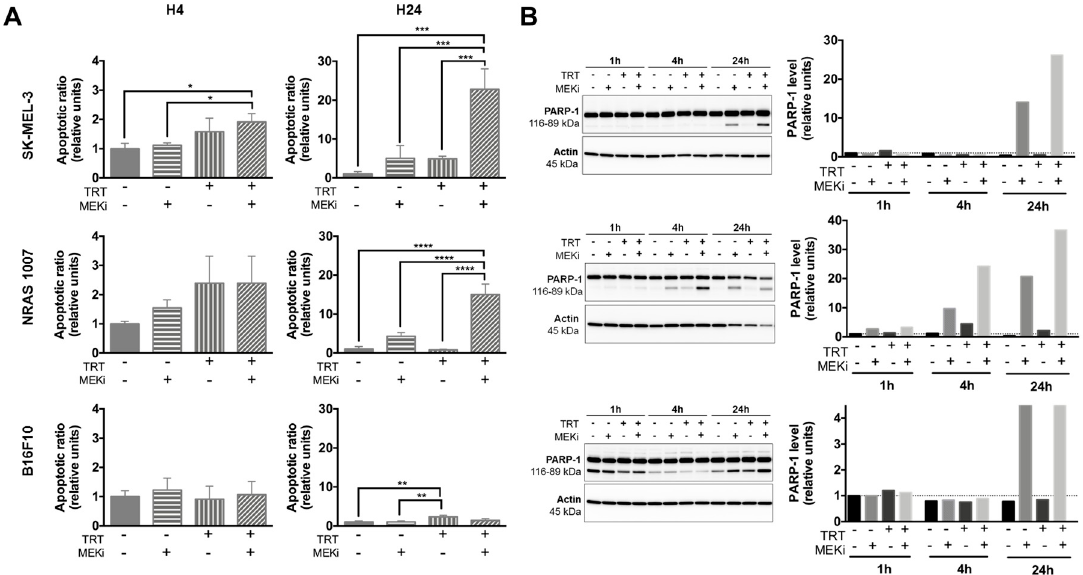
Figure 1. Apoptosis assays (n = 3) on melanoma spheroids after treatment with [ 131 I]ICF01012-targeted radionuclide therapy (TRT), MEK inhibitors (MEKi), or both. Results are presented as mean +/ − SD ( A ). ( A ) Apoptosis was assessed by quantification of soluble nucleosomes in cells using an ELISA cell death for SK-MEL-3, NRAS 1007, and B16F10. ( B ) Western blot analysis of cleaved PARP-1 in SK-MEL-3, NRAS 1007, and B16F10 spheroids treated with TRT, MEKi, or both. Actin was used as a protein-loading control. For Western blot, spheroids from 3 different experiments were pooled. For Western blot graphs, y-scales are not identical between cell lines. (* p < 0.05, ** p < 0.01, *** p < 0.001, **** p <